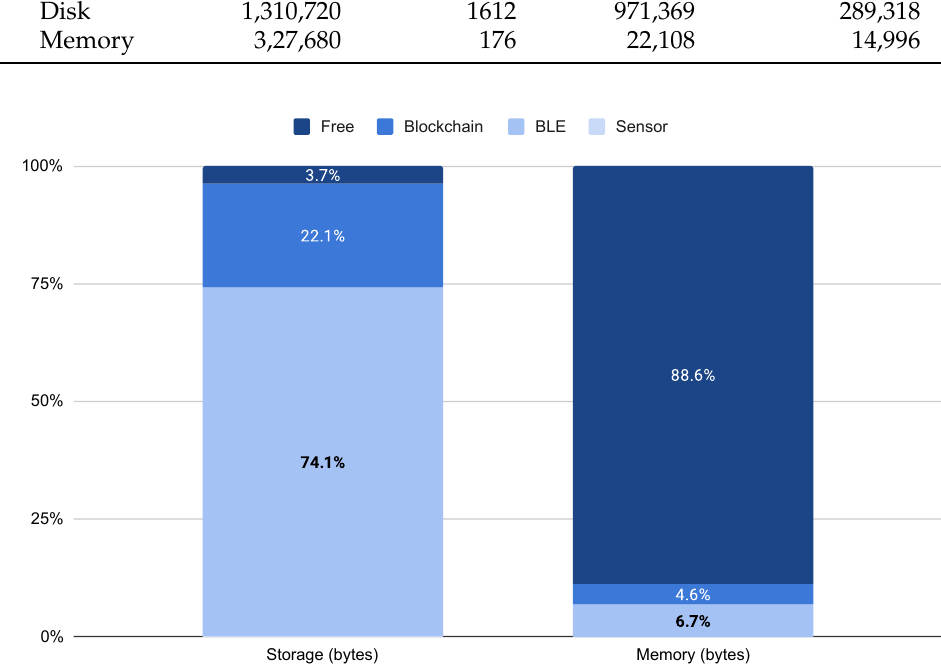
Figure 4. Disk and memory usage normalized to the total